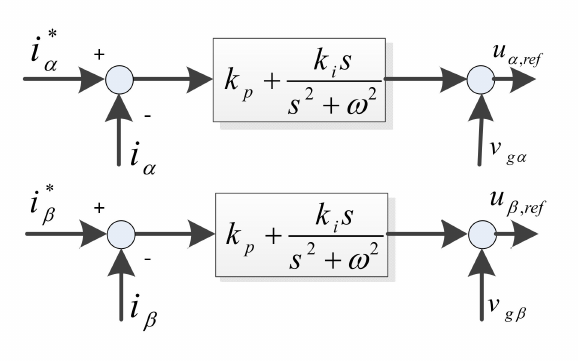
Figure 5. Standard ideal PR controller in the stationary reference frame.